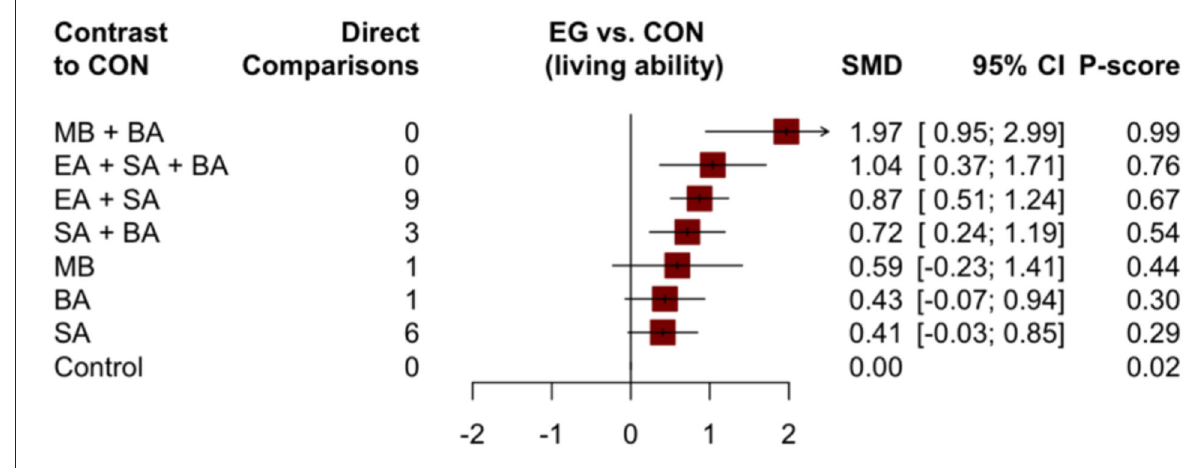
FIGURE8 Forest plot compared with the control group (living ability).